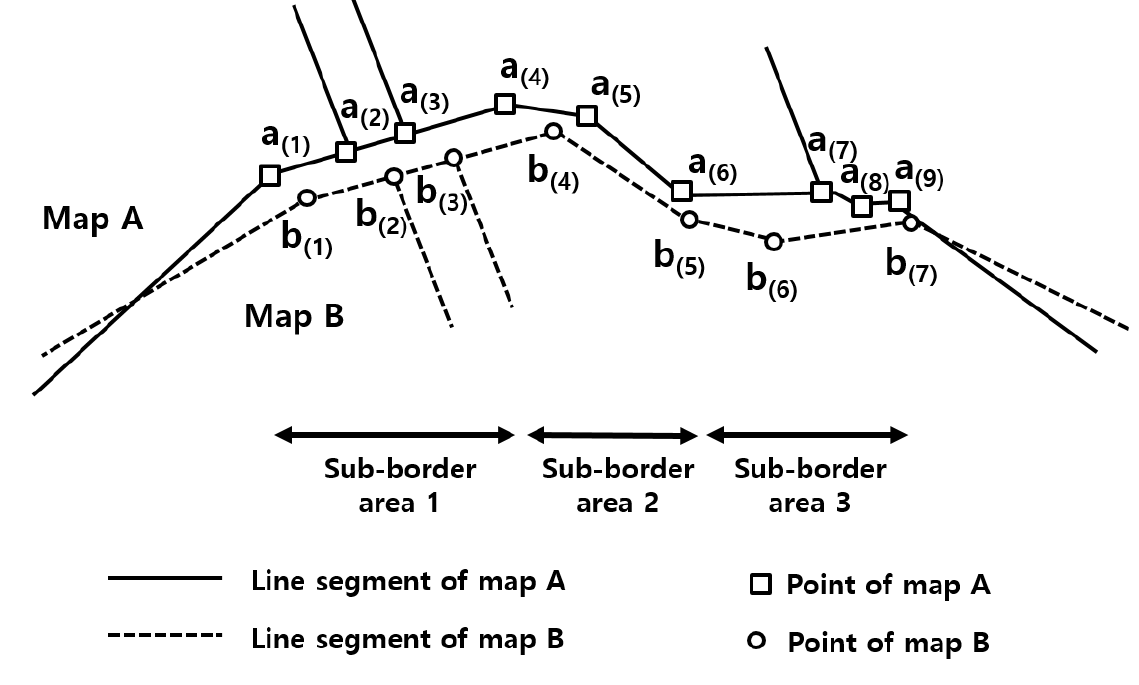
Figure 1. Positional differences between adjacent spatial